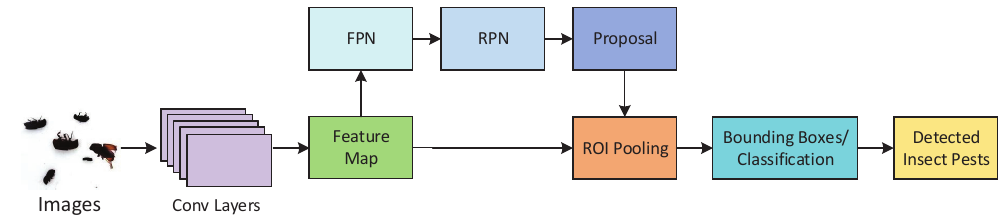
Figure 10. Faster-RCNN ResNet50 model.